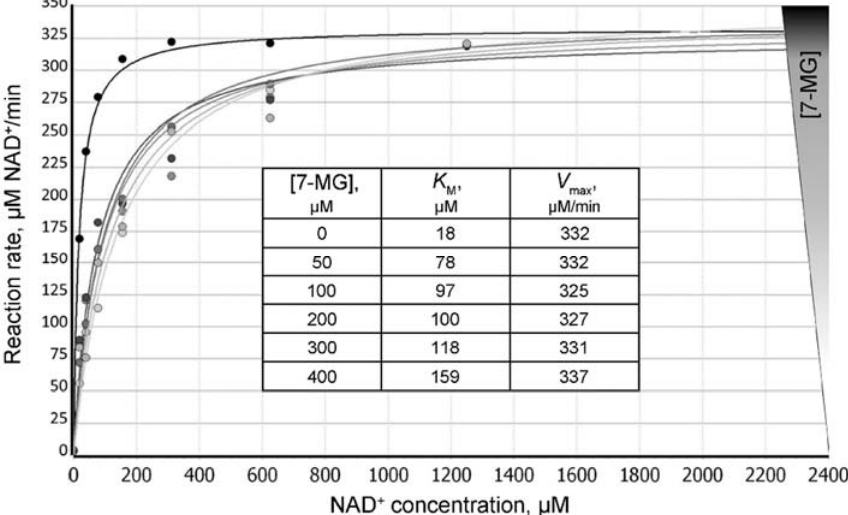
Figure 3. Dependence of the PARP ‐ 1 ‐ catalyzed reaction rate on the NAD + concentration at different concentrations of 7 ‐ MG added to the reaction mixture. Insert: calculated K M app values increase with increasing 7 ‐ MG concentrations, thus demonstrating the competitive inhibition mechanism.